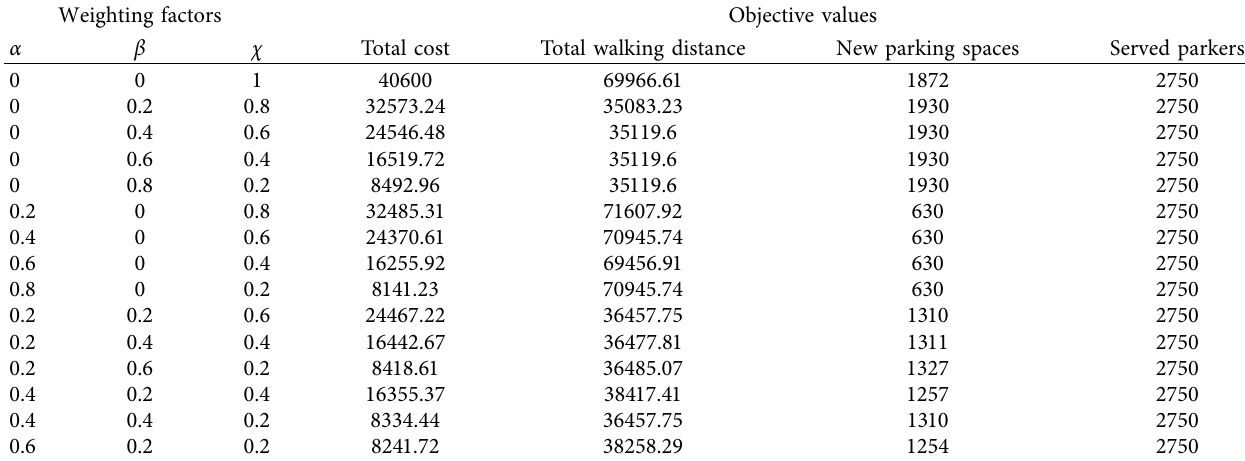
Table 3: The optimal results of different weighting factor